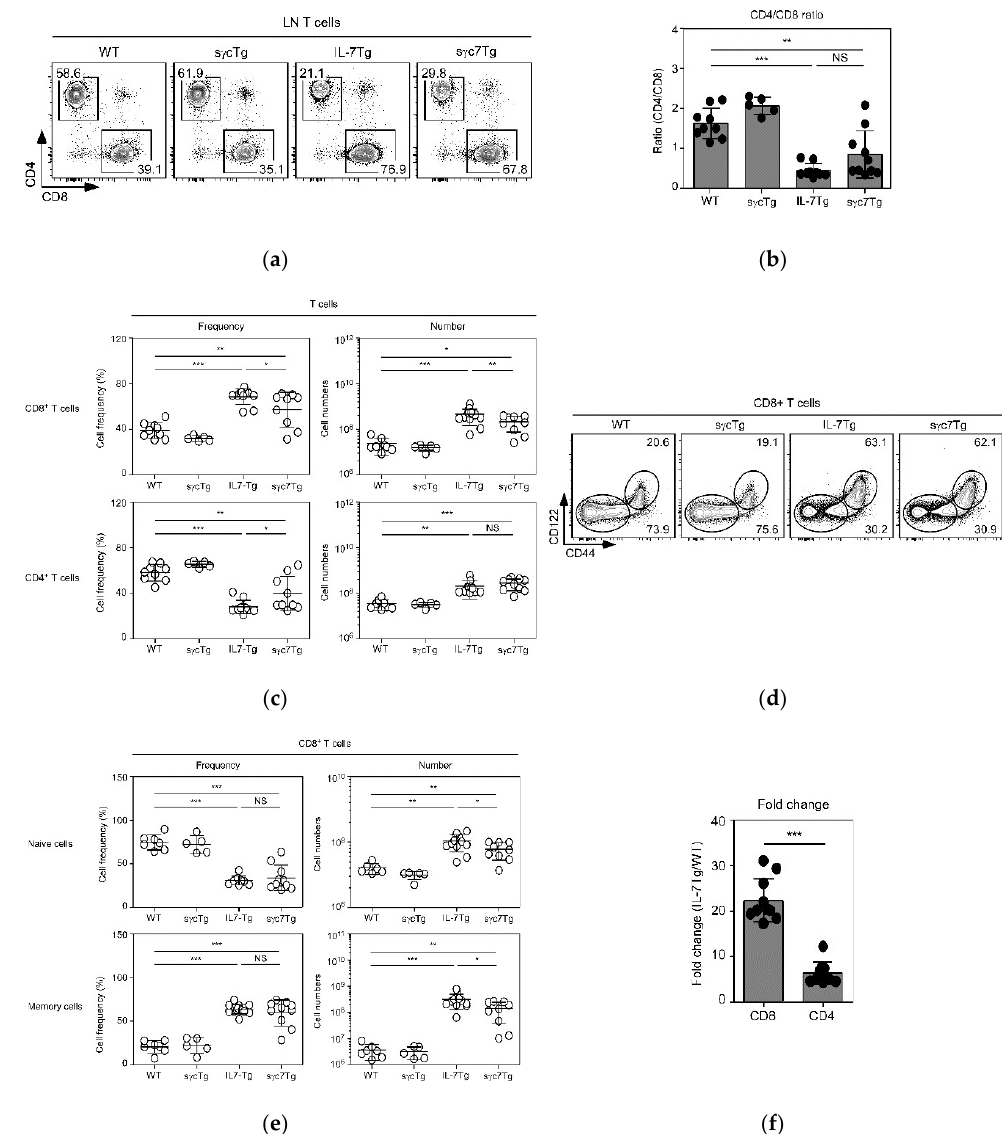
Figure 3. Analysis of CD4+ and CD8+ LN T cells. ( a ) Contour plots show CD4/CD8 profiles and percentages of CD4+ and CD8+ T cells, respectively. ( b ) CD4/CD8 ratio in the indicated mice. Each symbol represents an indicated individual mouse. Error bars represent mean and SD. ( c ) Summary of frequency and total numbers of CD4+ and CD8+ T cells in the indicated mice. Each symbol represents an indicated individual mouse. Horizontal lines indicate mean and SD. ( d ) Contour plots show CD44/CD122 profiles and percentages of CD44−CD122low naïve and CD44+CD122hi memory T cells, respectively. ( e ) Naïve- and memory-phenotype analysis of CD8+ T cells. Frequency and total numbers of naive and memory CD8+ T cells in the indicated mice were analyzed. Each symbol represents an indicated individual mouse. Horizontal lines indicate mean and SD. ( f ) Fold change of CD4+ and CD8+ T cells between IL-7Tg and WT mice. Each symbol represents an indicated individual mouse. Error bars represent mean and SD. * p < 0.05, ** p < 0.01, *** p < 0.001, and NS mean not significant.